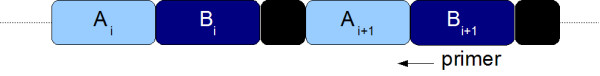
DNA One-Time pad. Ai: plain text, Bi: cipher text (and primer for the DNA polymerase), black box: stop Modified from Gehani et al. [2].